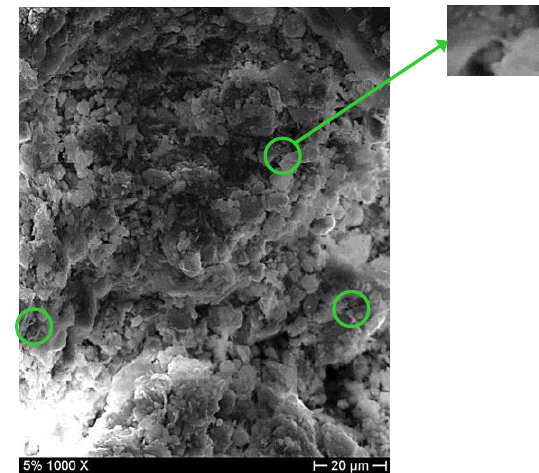
Figure 12. TQ5 at 28 d mellowing period—1000X.